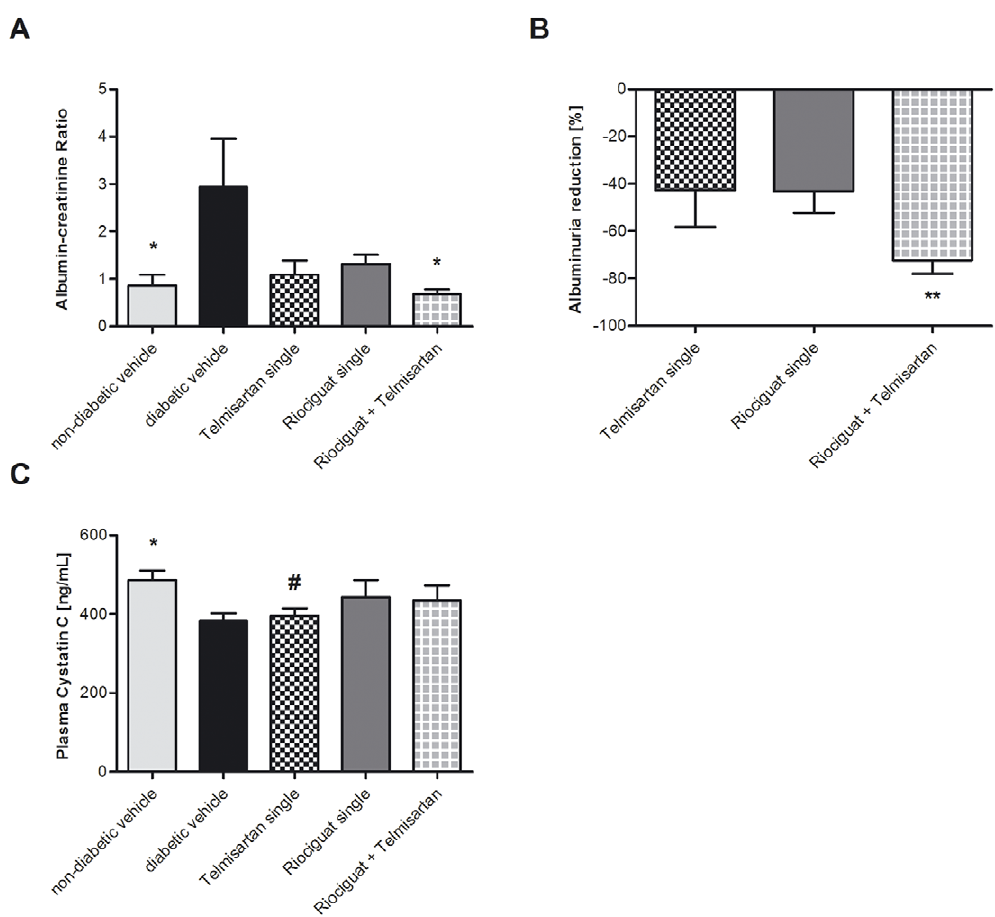
Figure 1. Significant reduction of albuminuria by combination therapy: Final kidney parameters in diabetic eNOS knockout mice treated with riociguat (3 mg/kg/d), telmisartan (1 mg/kg/d), both (3 mg/kg/d and 1 mg/kg/d) or vehicle, and non-diabetic eNOS knockout mice treated with vehicle, respectively. Urinary albumin-creatinine ratio (A), percentage reduction in urinary albumin excretion per day compared with diabetic controls (B) and cystatin C in Plasma (C). Values are given as means 6 SEM. For comparisons, student’s t test and Mann- Whitney u test, respectively, were used. * p , 0.05 vs. diabetic vehicle; # p , 0.05 vs. non-diabetic vehicle.